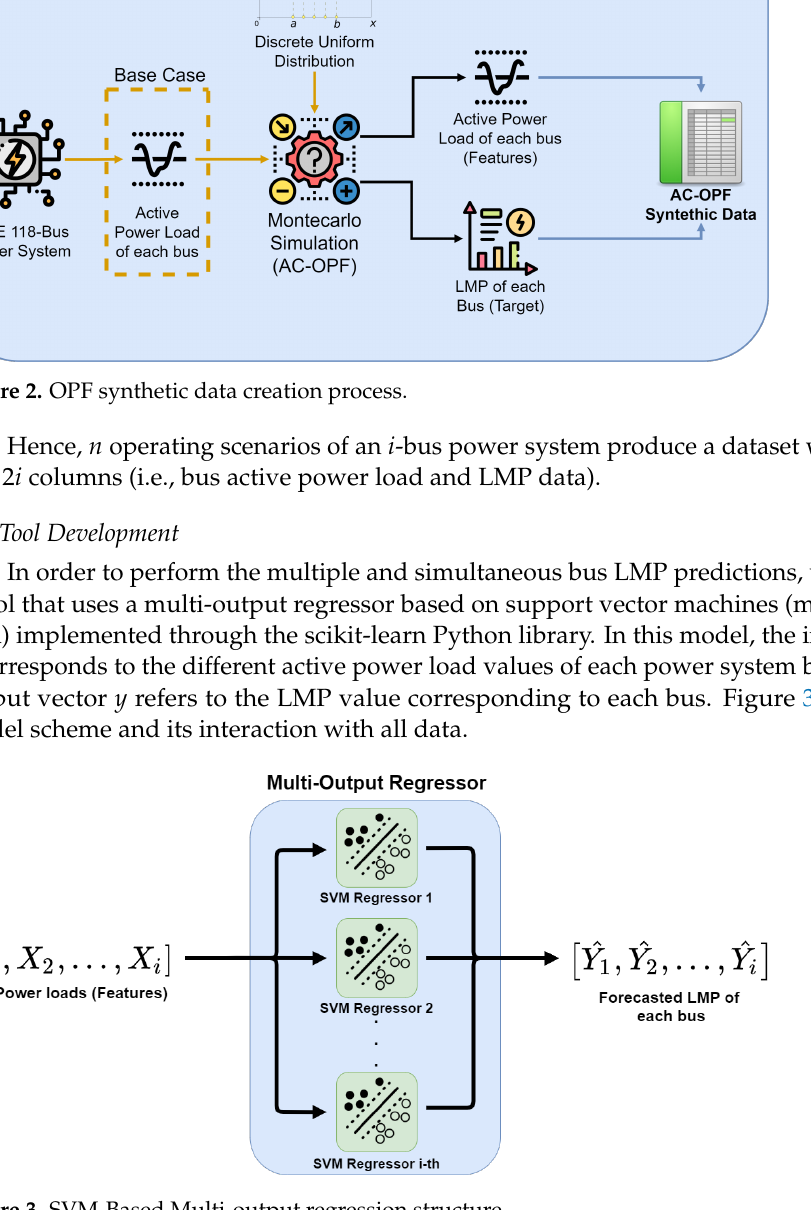
Figure 3. SVM-Based Multi-output regression